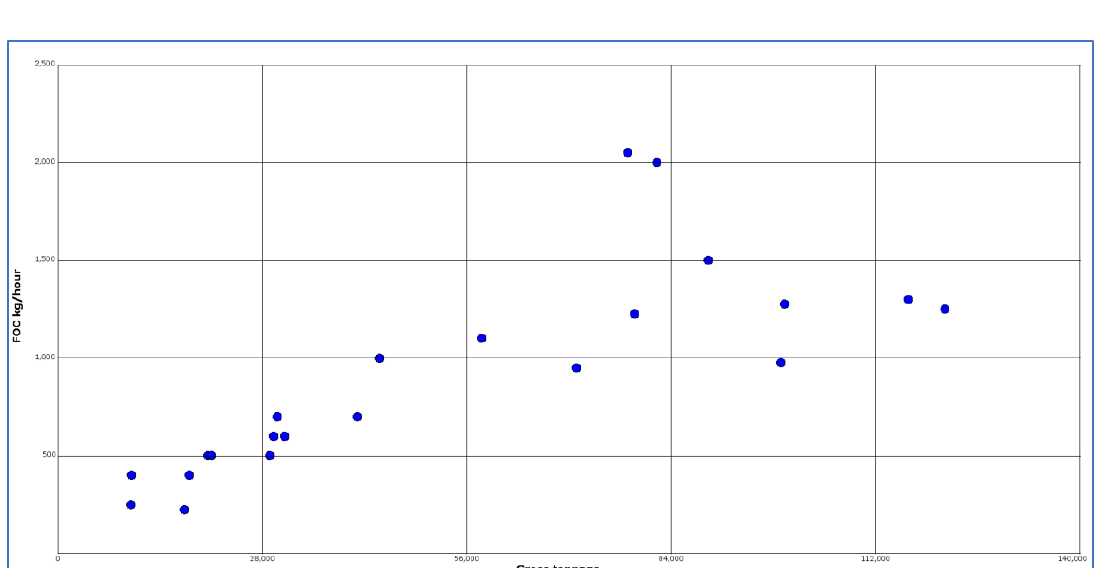
Figure 2. Reconstruction of Marintek figure.